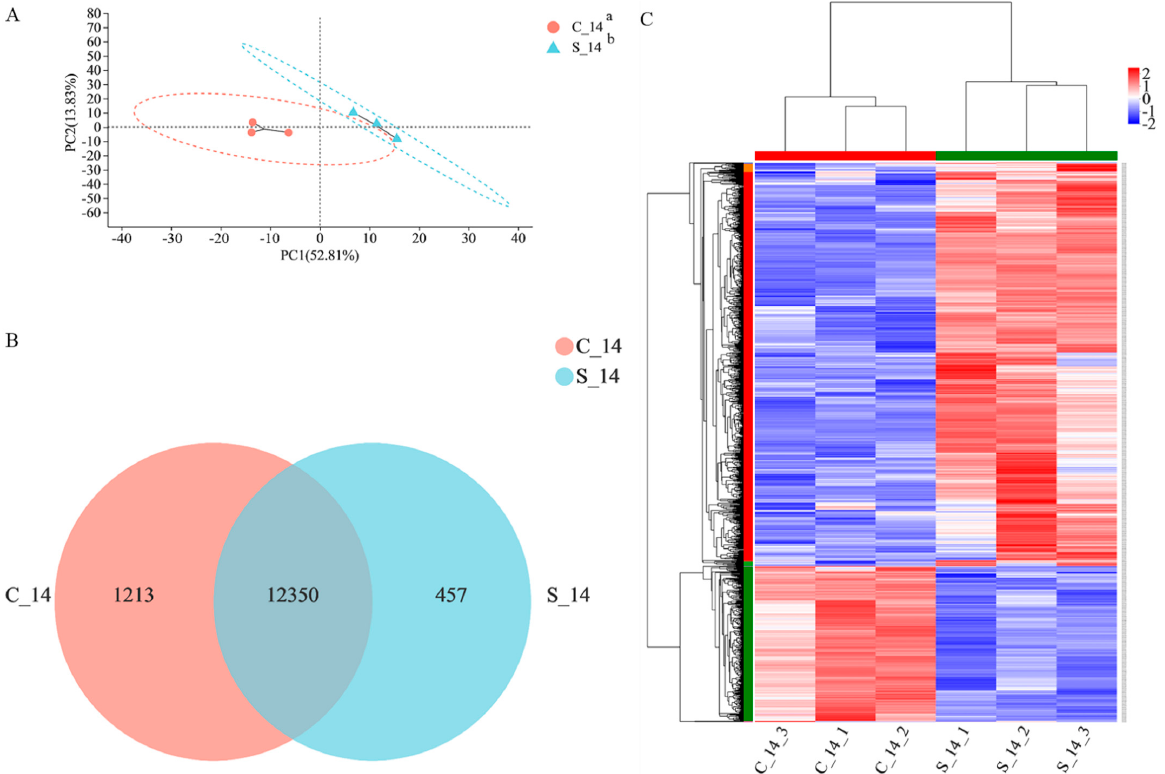
Figure 2. ( A ) Principal component analysis (PCA) based on mRNA expression. ( B ) Venn diagram illustrating DEGs in the QBLP treatment groups relative to the control group. ( C ) Heatmap of mRNA expression profiles. a C_14 indicates the control group (no additional QBLP was added to the medium). b S_14 indicates the treatment group ( C. elegans treated with 0.2 g/L QBLP for 14 days).